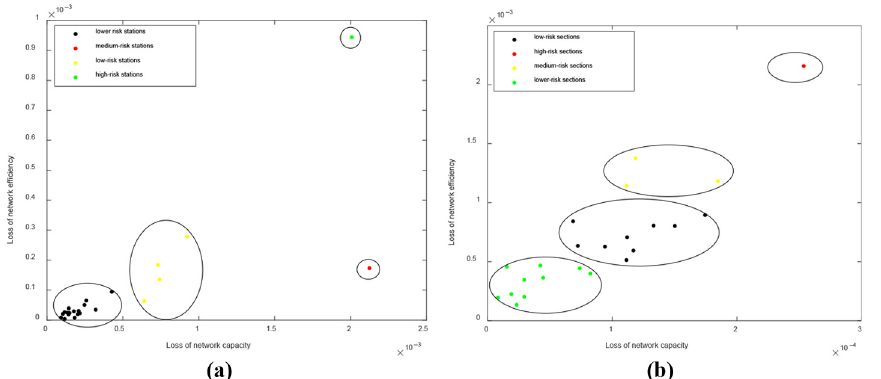
Figure 4. Safety critical stations and